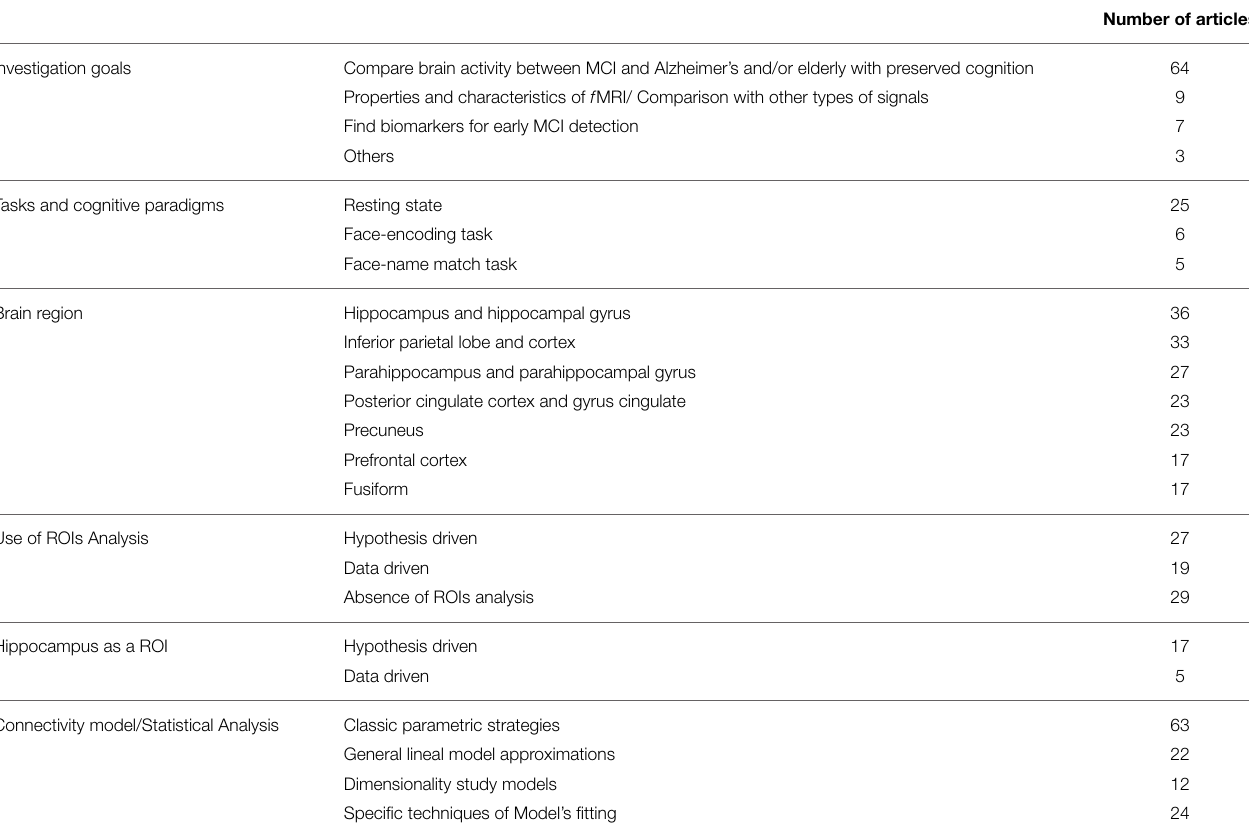
TABLE 3 | Summary of research goals, use of ROI analysis, brain regions, and statistical analysis in the